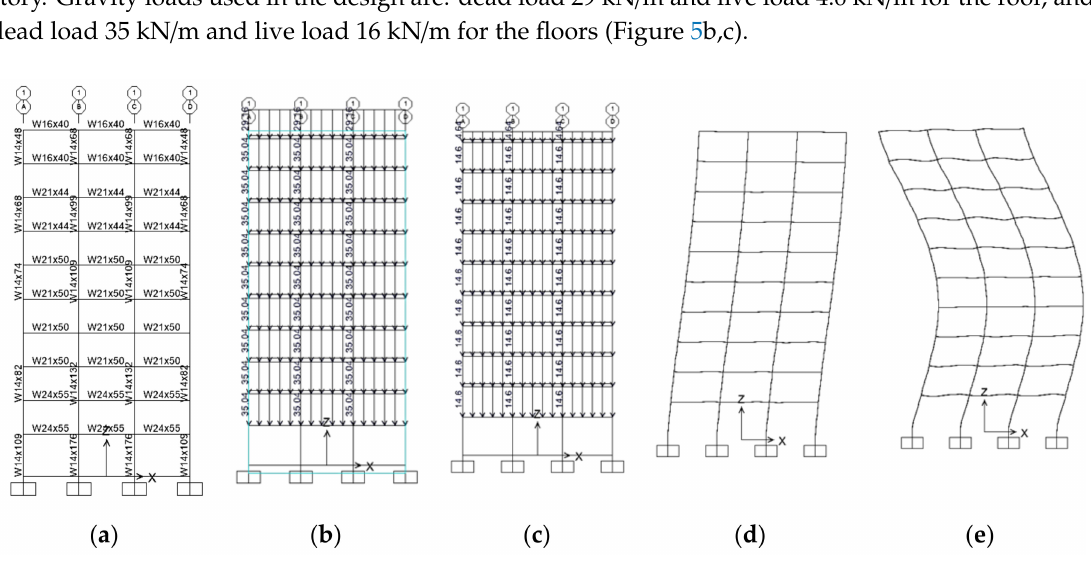
Figure 5. Ten-story steel frame resisting structure [28]; ( a ) sections; ( b ) dead load 35 kN / m ;( c ) live load 14.6 kN / m ; ( d ) deformed shape of the first mode T = 2.27 s; ( e ) deformed shape of the second mode T = 0.79